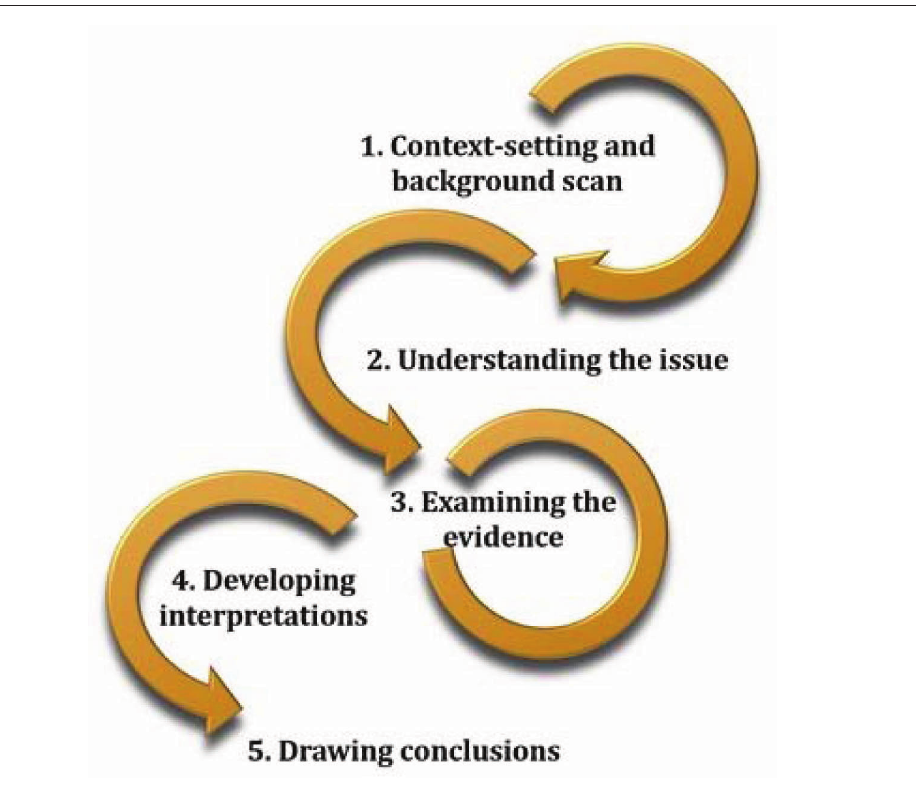
Figure 2: Instructional